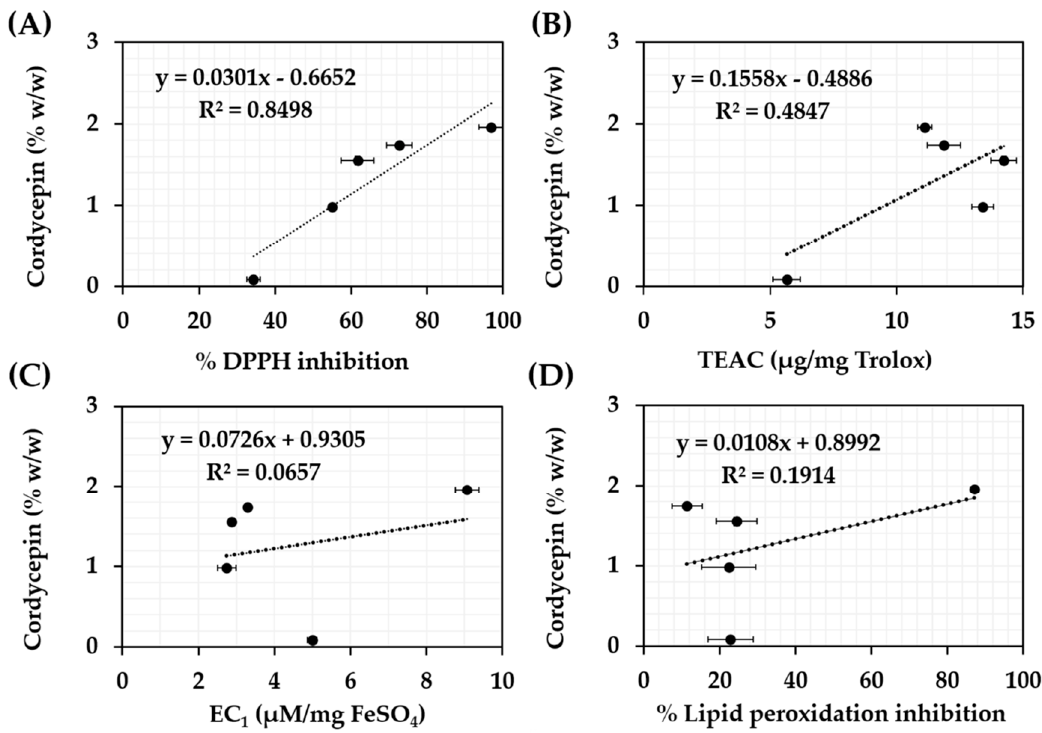
Figure 1. Correlations between cordycepin content and antioxidant activities of C. militaris extracts investigated by 2,2 (cid:48) -diphenyl-1-picrylhydrazyl (DPPH) assay ( A ), 2,2 (cid:48) -azino-bis3-ethylbenzothiazoline-6-sulfonic acid (ABTS) assay ( B ), ferric reducing antioxidant power (FRAP) assay ( C ), and ferric thiocyanate (FTC) assay ( D ).